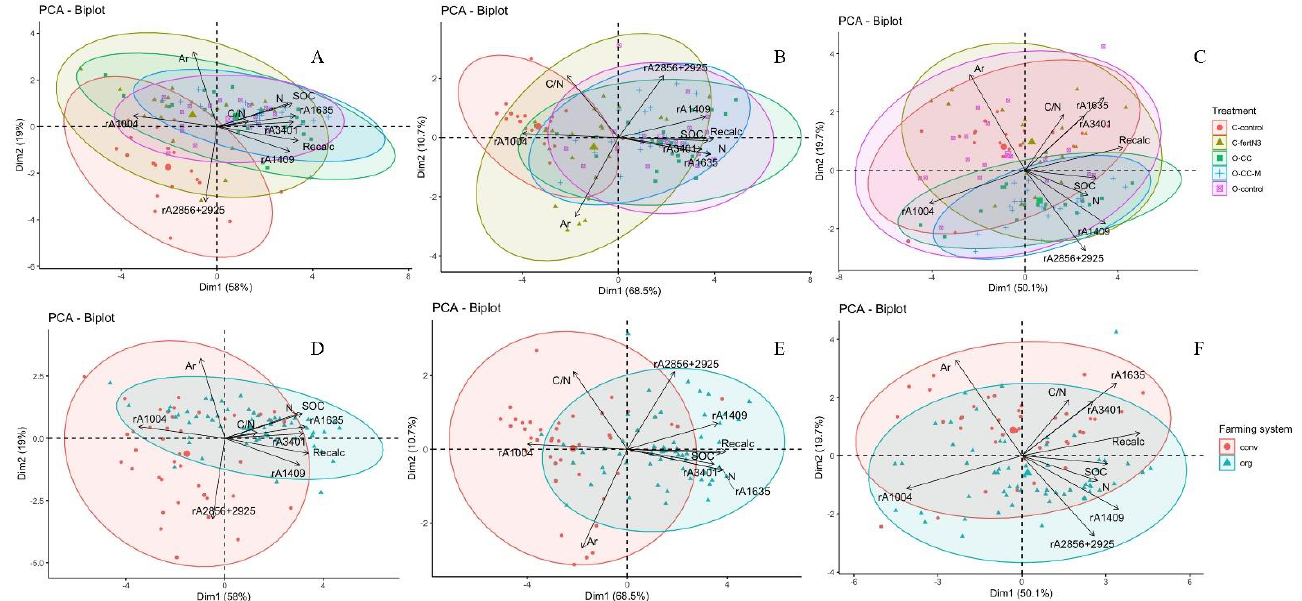
Figure 7. Principal component analysis (PCA) biplot of relative absorbances (rA) and other indices (C/N ratio, C and N concentrations, recalcitrance (Recalc), and aromaticity (Ar) of the bulk soil and fractions depending on treatment (( A ) bulk soil, ( B ) POM and ( C ) MAOM) or farming system (( D ) bulk soil, ( E ) POM, and ( F ) MAOM.